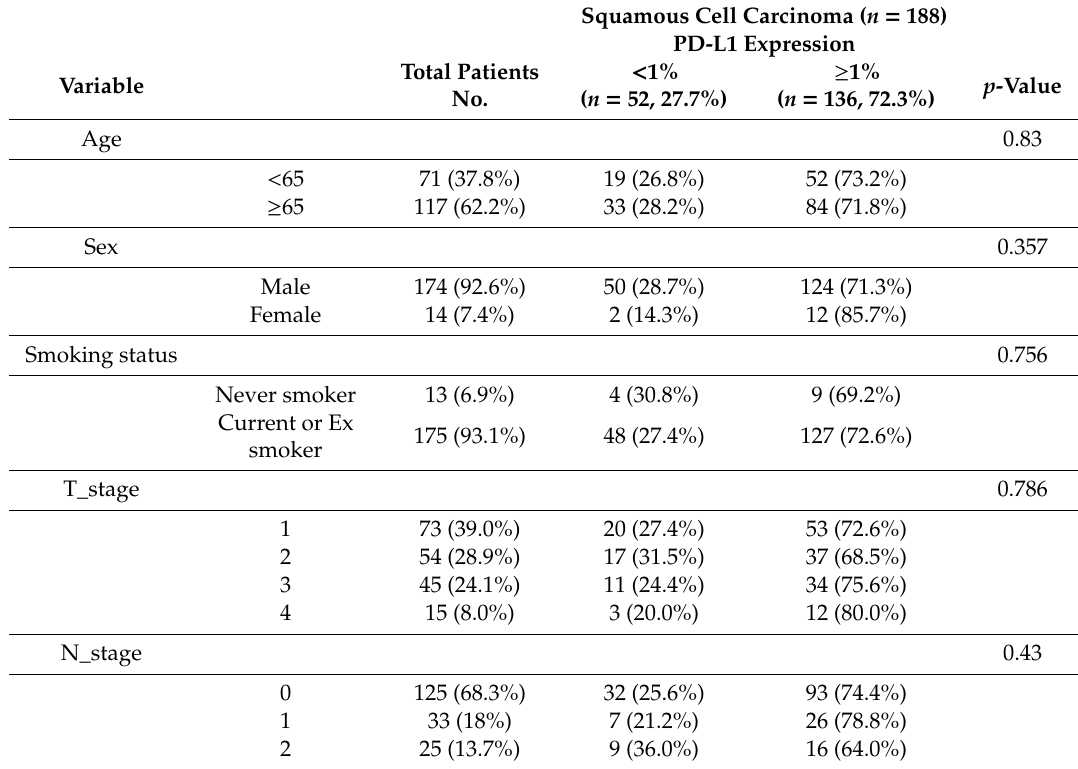
Table A2. Association between PD-L1 expression status and clinicopathological features in 188 lung squamous cell carcinoma (1% cuto ff